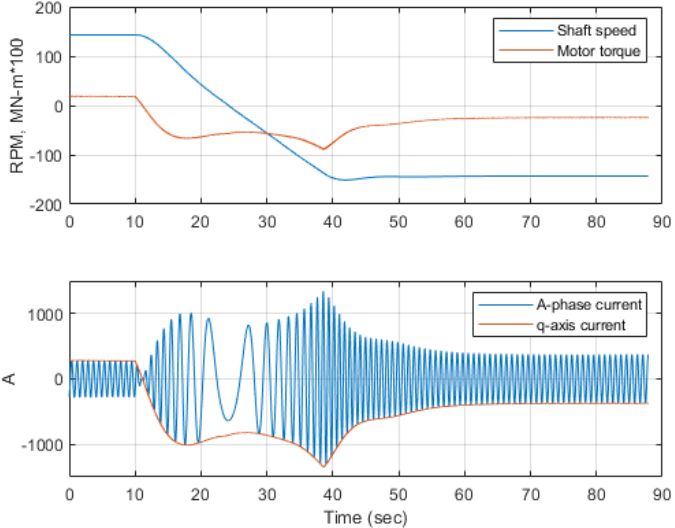
Figure 18. Motor performance during crash back test.